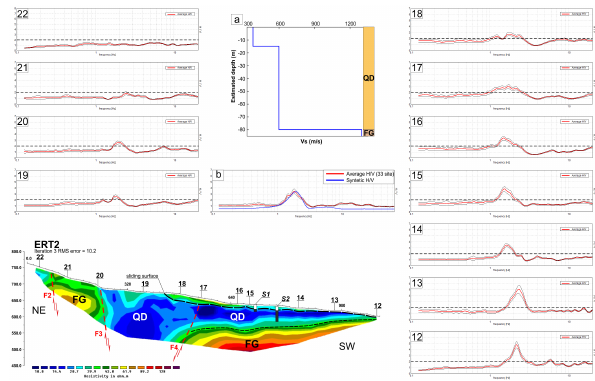
Figure 6. Comparison between the ambient noise HVSRs and the ERT2. 12 to 22 indicate the HVSR curves from seismic noise measurements. (a) Value of V s used to constrain the H/V curve. (b) Comparison between the synthetic HVSR curve and the ambi- ent noise HVSR curve at the site